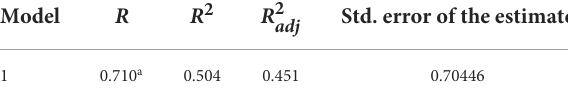
TABLE 10 Fitted model